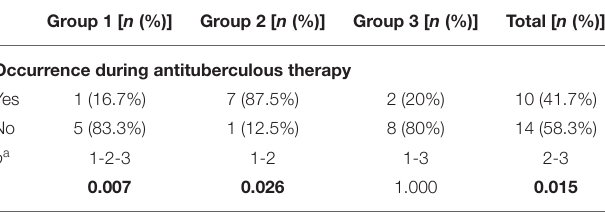
TABLE 2 | The incidence of intraspinal tuberculoma during antituberculous therapy among the three groups. Group 1 [ n (%)] Group 2 [ n (%)] Group 3 [ n (%)] Total [ n (%)] Occurrence during antituberculous